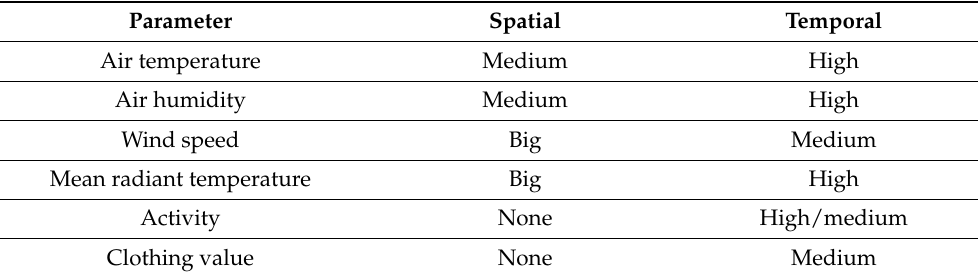
Table 3. Spatial and temporal variability of meteorological input parameters for thermal indices.